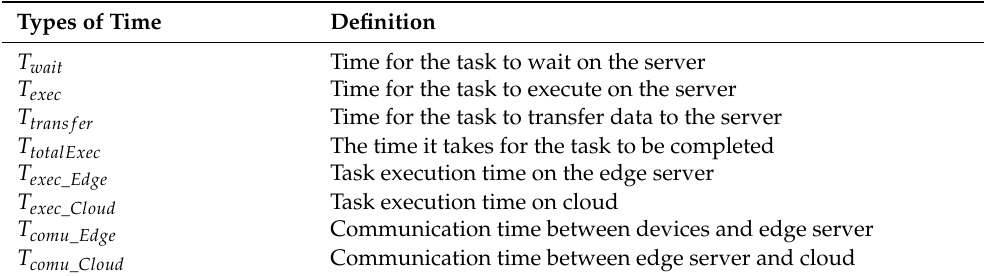
Table 2. Definition of different types of time in edge-cloud collaborative computing